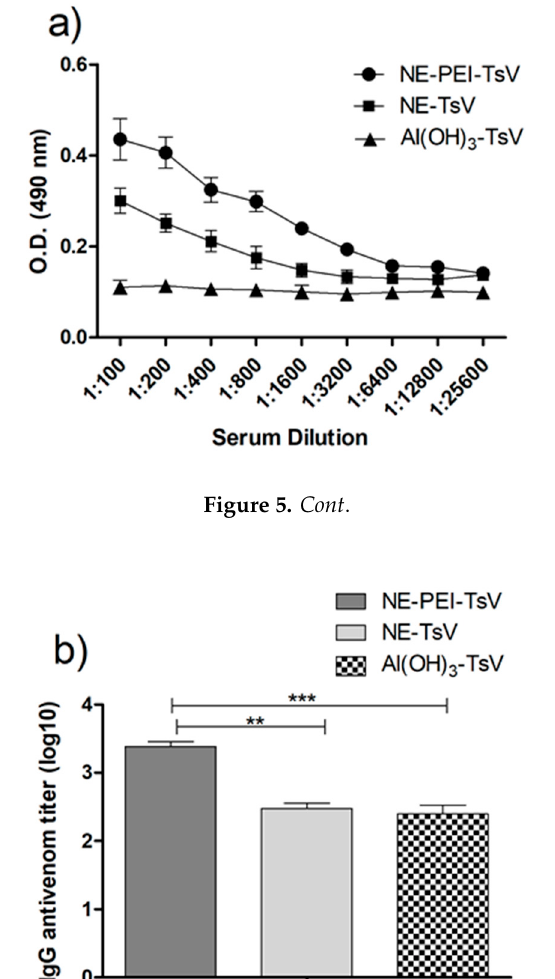
Figure 5. ( a ) Evaluation of the optical density profile from antibodies produced by mice immunized subcutaneously for 6 weeks with 0.0018 mg of TsV using the three tested adjuvants, ( b ) Antivenom IgG titer from mice immunized subcutaneously for 6 weeks with 0.0018 mg of TsV using the three tested adjuvants. The comparisons were performed using the one-way ANOVA followed by Tukey’s post-test. A p < 0.05 was represented as *, p < 0.01 as ** and p < 0.001 as ***.